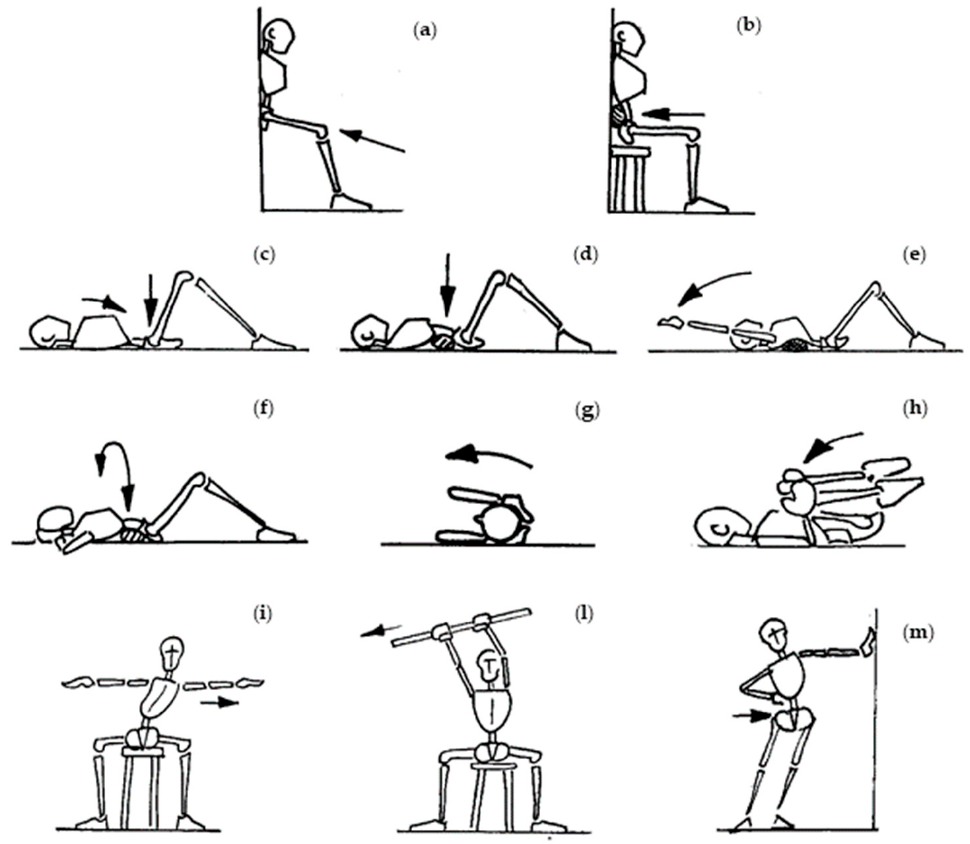
Figure 5. Visual explanation of home ‐ based exercises. Exercises ( a ) and ( b ) aimed to increase the spine’s stability. Exercises ( c – h ) aimed to reduce pain perception. Exercises ( i – m ) aimed to increase spine mobility.